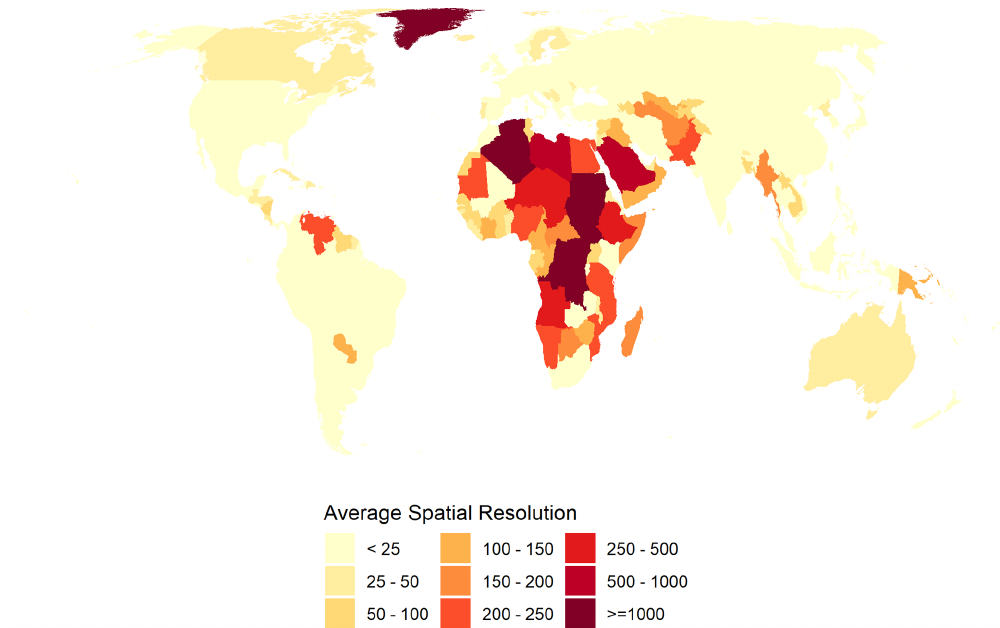
Figure 6. The average spatial resolution of the regional accounts data by country (World Bank, 2019). See also the various sources in the